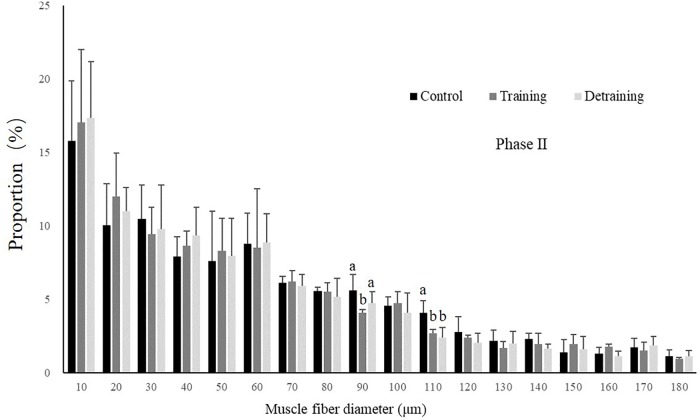
Distribution of fiber size in the control, training, and detraining groups (mean ± SD) in Phase II (n = 12). Different letters indicate significant differences in the same muscle fiber diameter range between the experimental groups (P < 0.05).